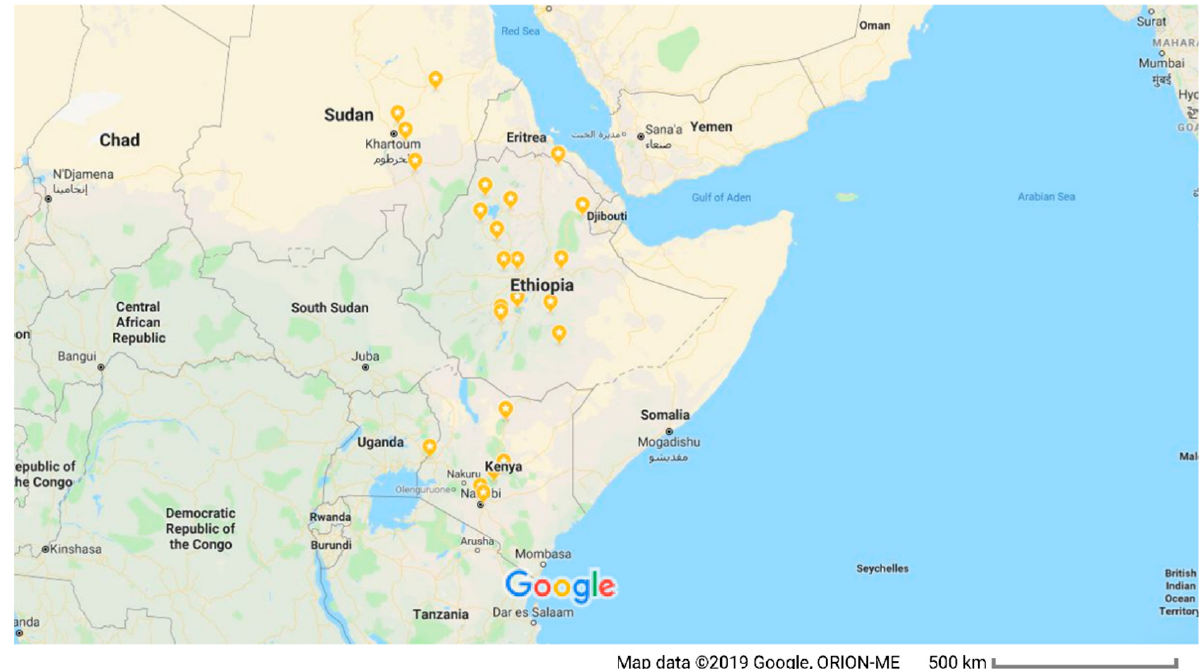
Figure 1. Map of East Africa showing Sudan, Kenya, and Ethiopia, and the approximate geographical origins (highlighted in orange) of LSDV isolates included in this study.